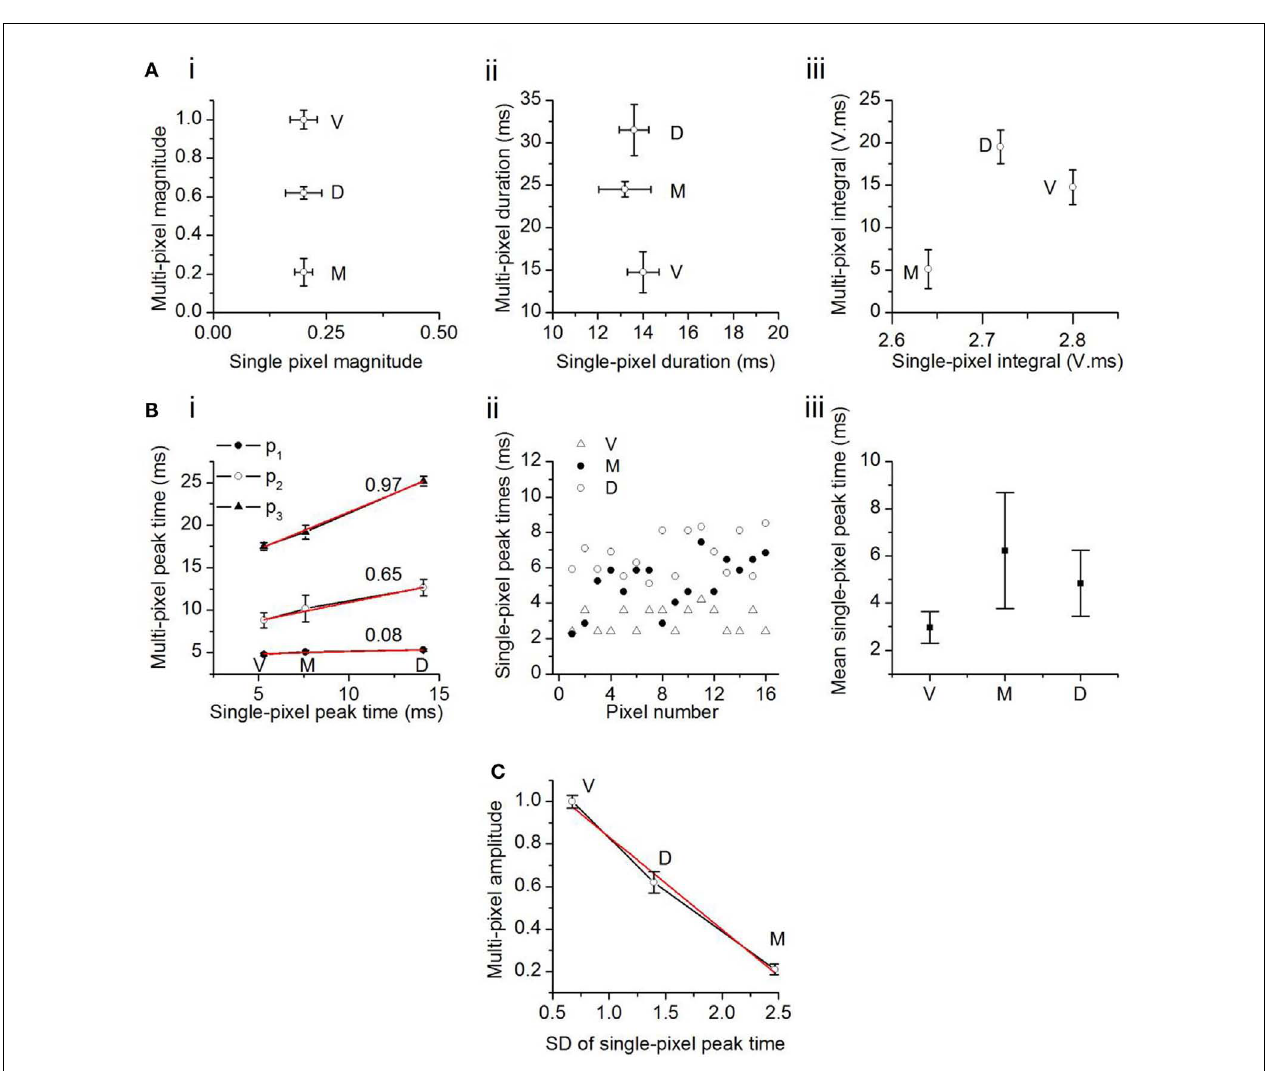
indicated.V, ventral; M, medial; D, dorsal ICC. (ii) Distribution of single pixel peak times in the ventral, medial, and dorsal regions in one slice. Pixels chosen are the same 16pixels used for multi-pixel analysis in that slice. (iii) Mean single-pixel peak time in the ventral, medial, and dorsal ICC.Values are mean and SD of data from 14 transverse slices. (C) Maximum amplitude of the multi-pixel response plotted as a function of the SD of the scatter in single pixel peak times. Data from 14 transverse slices. Error bars are SEM. Red line, linear fit, r 2 =